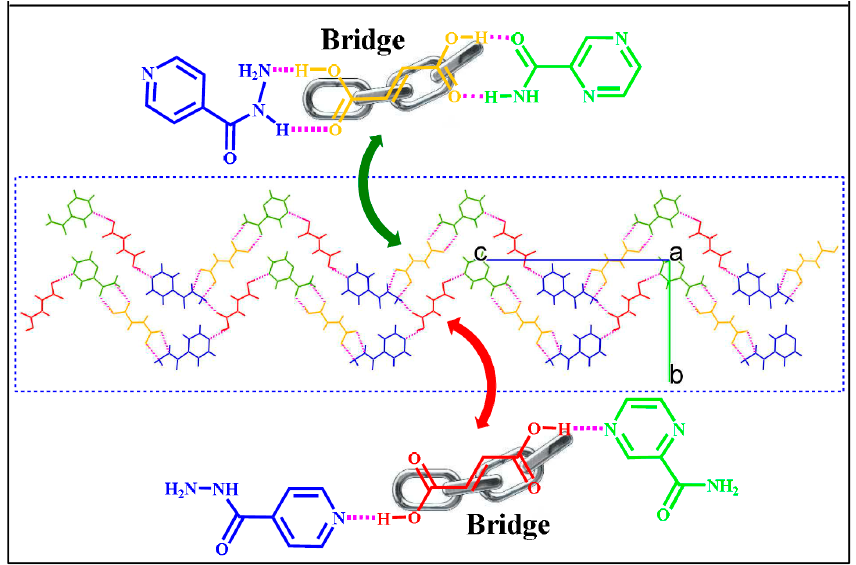
Figure 8. Molecular structures of INH, Pyz, and FA; crystal structure of INH-FA-Pyz ternary cocrystal. Adapted with permission from Cryst. Growth Des. , DOI: 10.1021/acs.cgd.7b01738. Copyright 2018, American Chemical Society.